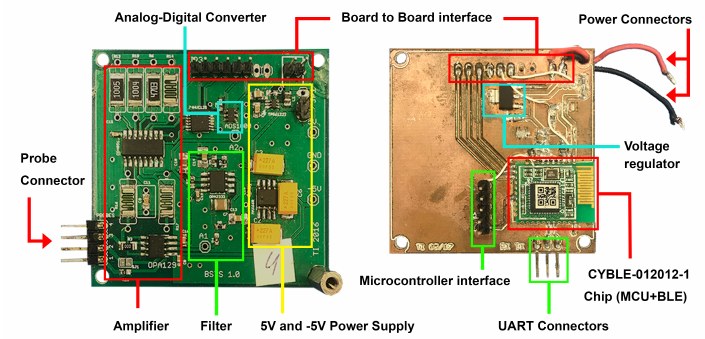
Figure 4. BLE moisture device circuit: analog and digital boards. The size of the circuit when the boards are connected: 5.7 cm × 5.3 cm × 1.5